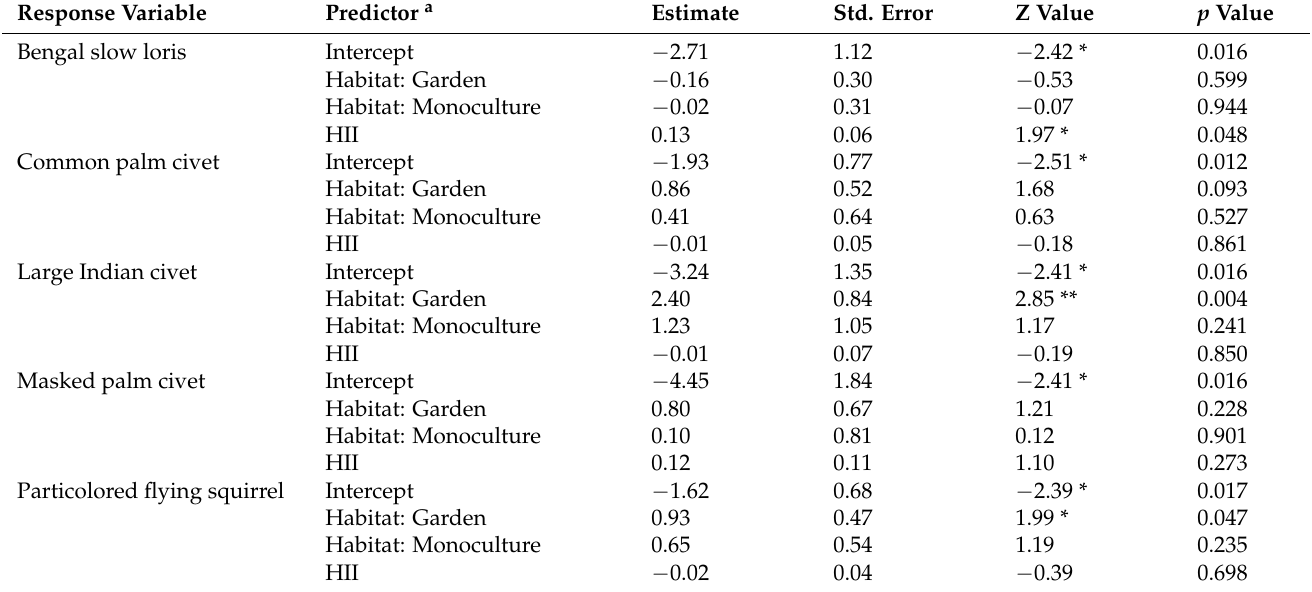
Table 3. Results of the generalized linear mixed models with the encounter rates of nocturnal species as the response variable and habitat type and the Human Influence Index (HII) as